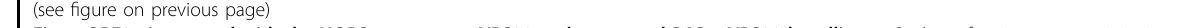
Fig. 5 ORF3a interacted with the HOPS component VPS39 and prevented RAB7 – VPS39 bundling. a Outline of co-immunoprecipitation and mass spectrometry experiments performed to identify ORF3a-interacting proteins in HeLa cells. b HOPS component VPS39 was the candidate among the ORF3a-interacting proteins identi fi ed by mass spectrometry at the highest con fi dent level. c Scheme showing the function of HOPS – RAB7 in autophagosome – lysosome fusion. d Two experimental studies on ORF3a-interacting proteins and our study simultaneously identi fi ed VPS39. e ORF3a directly interacted with VPS39. GST, GST-ORF3a, or His-VPS39 were expressed in bacteria. The puri fi ed proteins were used for GST pull-down assays and subsequent western blot analysis. f Schematic representation of ORF3a and the indicated Y160A mutant used to verify the VPS39 interaction and function in autophagy. g The Y160A mutation in ORF3a dramatically reduced the interaction between ORF3a and VPS39. GST, GST- ORF3a, the GST-ORF3a-Y160A mutant or His-VPS39 were expressed in bacteria. Puri fi ed proteins were used for GST pull-down assays and subsequent western blot analysis. h The Y160A mutation in ORF3a abolished its function in blocking autophagy. i ORF3a prevented the RAB7 interaction with VPS39. The RAB7 – VPS39 interaction was detected by co-immunoprecipitation assays with or without ORF3a expression. j ORF3a disrupted the assembly of SNARE. The interaction between SNARE components SNAP29 and VAMP8 was detected by co-immunoprecipitation assays with or without expression of ORF3a.